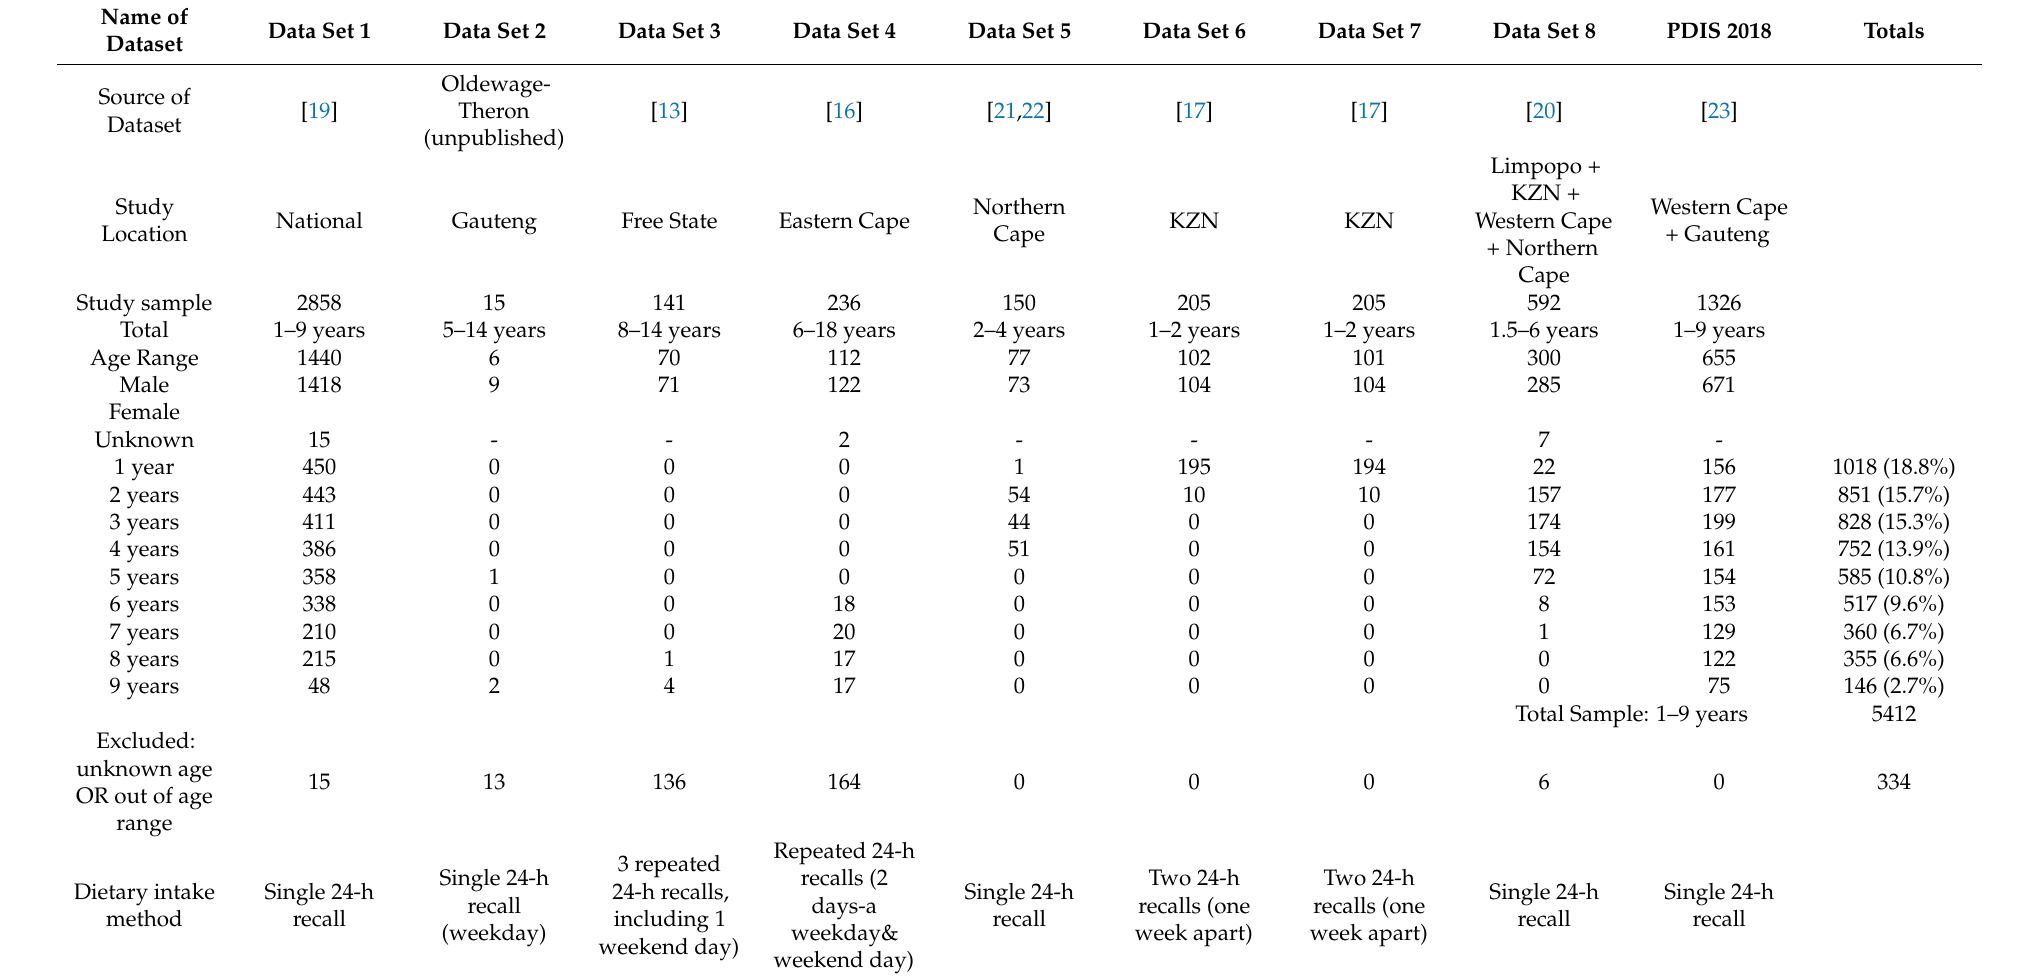
Table 1. Detail of dietary intake methodology for data sets used to calculate the South African childhood mean ± SD